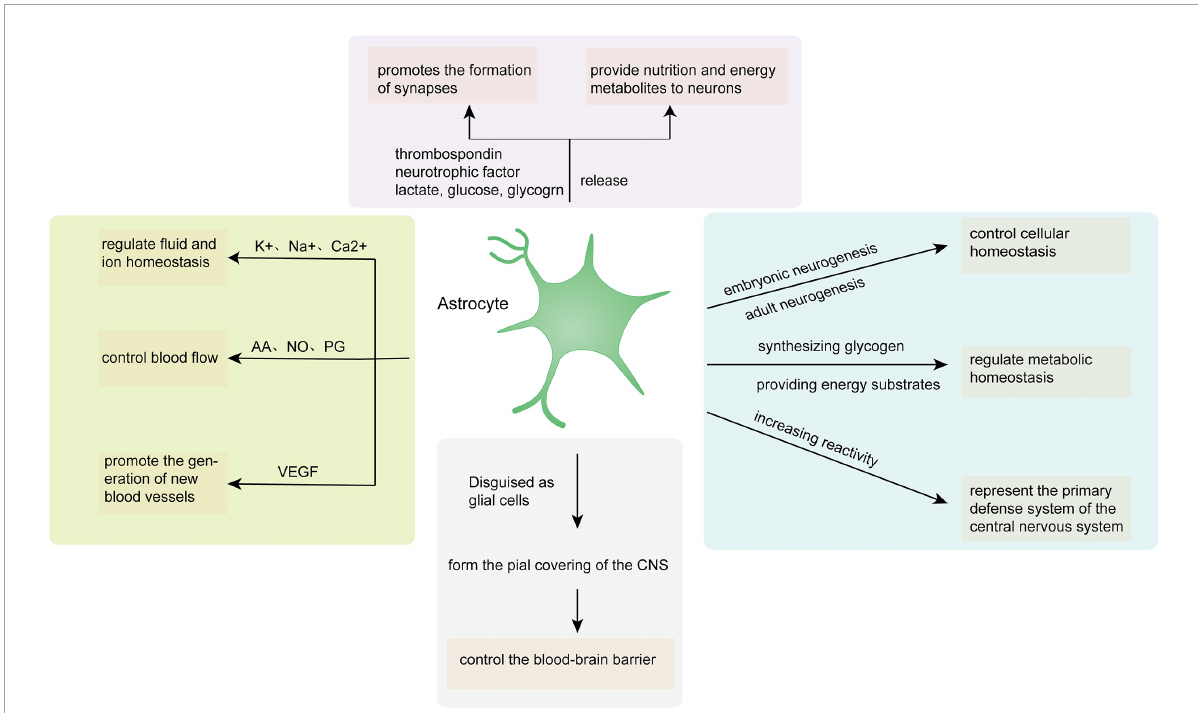
FIGURE1 Astrocyte functions in the CNS. AA, arachidonic acid; NO, nitric oxide; PG, prostaglandin; VEGF, vascular endothelial growth